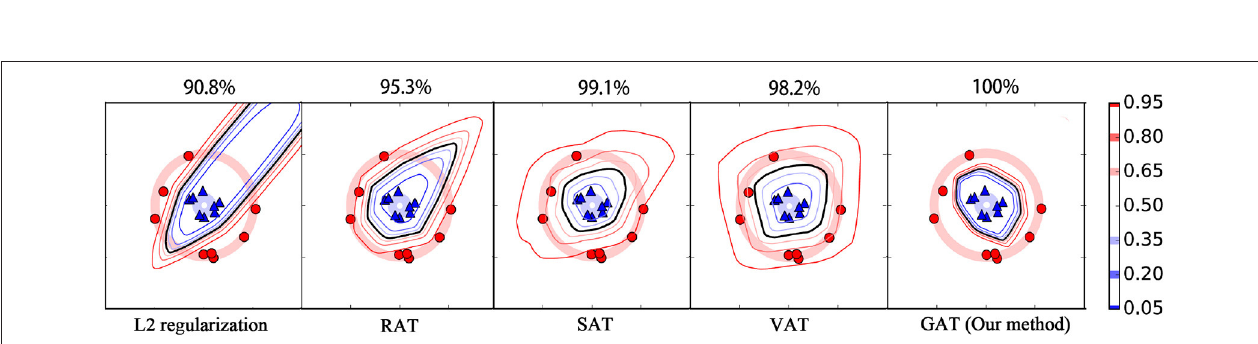
FIGURE 5 | The contour of output confidence for label 1 on C -dataset with various regularization methods. The detailed illustrations for this figure can be referred to the caption of Figure 4